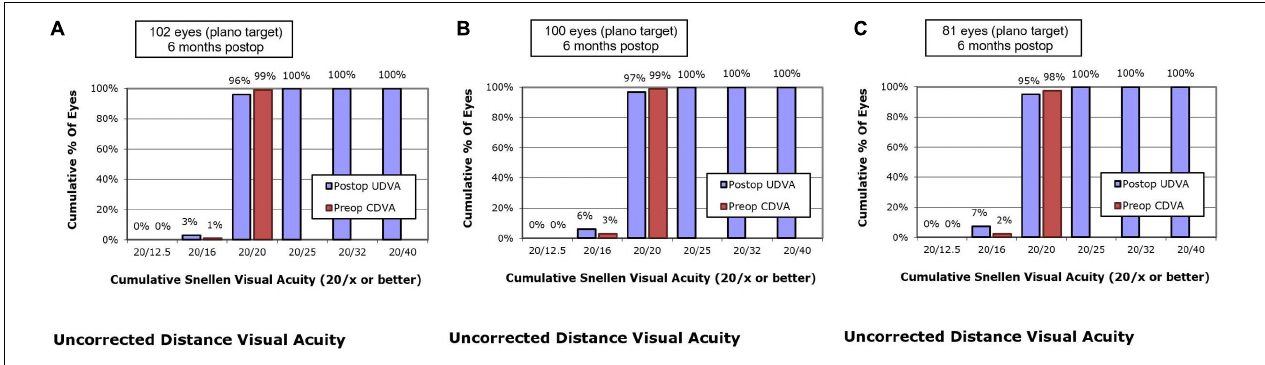
FIGURE 1 | Postoperative 6-month uncorrected distance visual acuity vs. preoperative corrected distance visual acuity. (A) SMILE group, (B) wavefront optimized group, (C) topography-guided custom ablation treatment